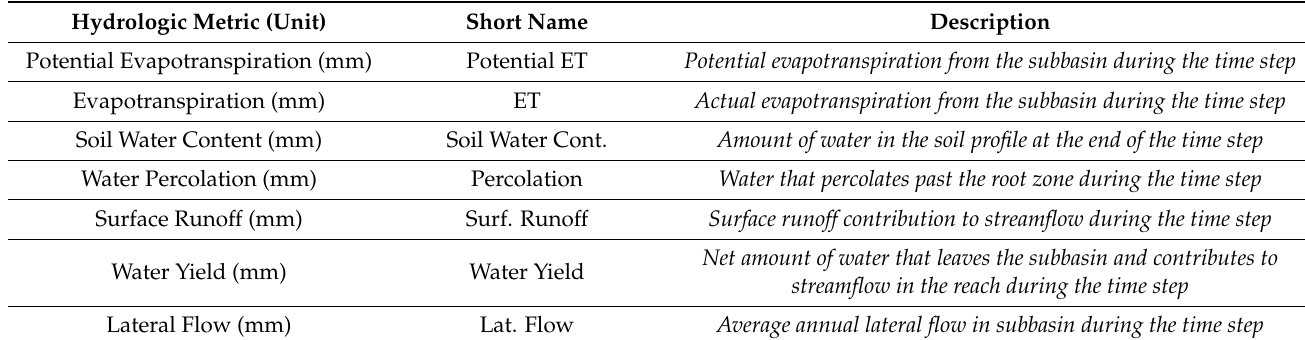
Table 1. Listing the modeled hydrologic metrics ( n = 7) for each sub-basin derived using the Soil & Water Assessment Tool (SWAT). Detailed descriptions of the hydrologic metrics are provided by the SWAT input/output file documentation [43] and listed here in